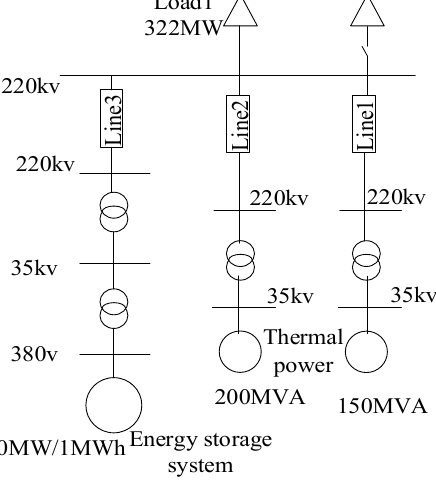
Figure 5. Schematic diagram of the simulation system.